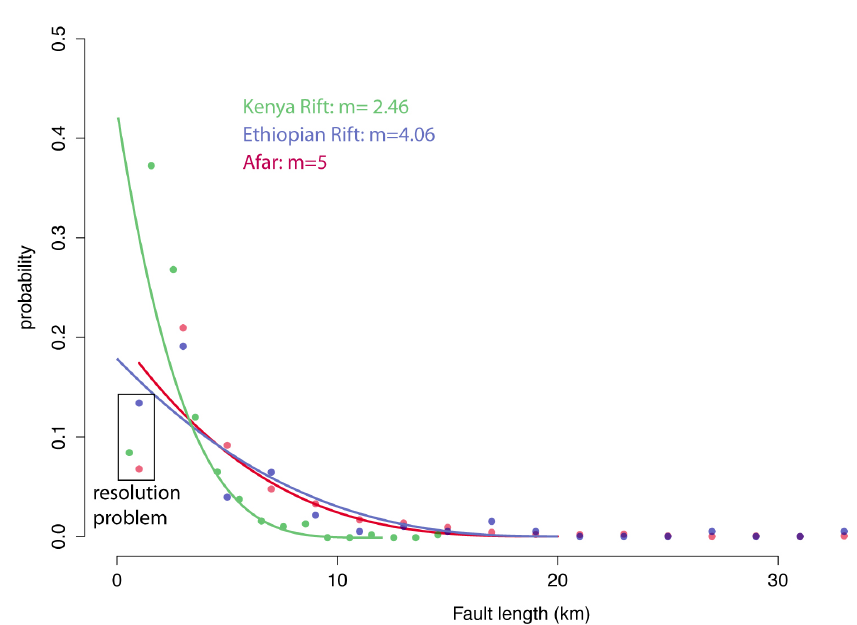
Fig. 3. Estimation of the Weibull moduli for fault systems in the Magadi (green, m =3.47), the MER (blue, m =4.06) and Afar (red, m =5).